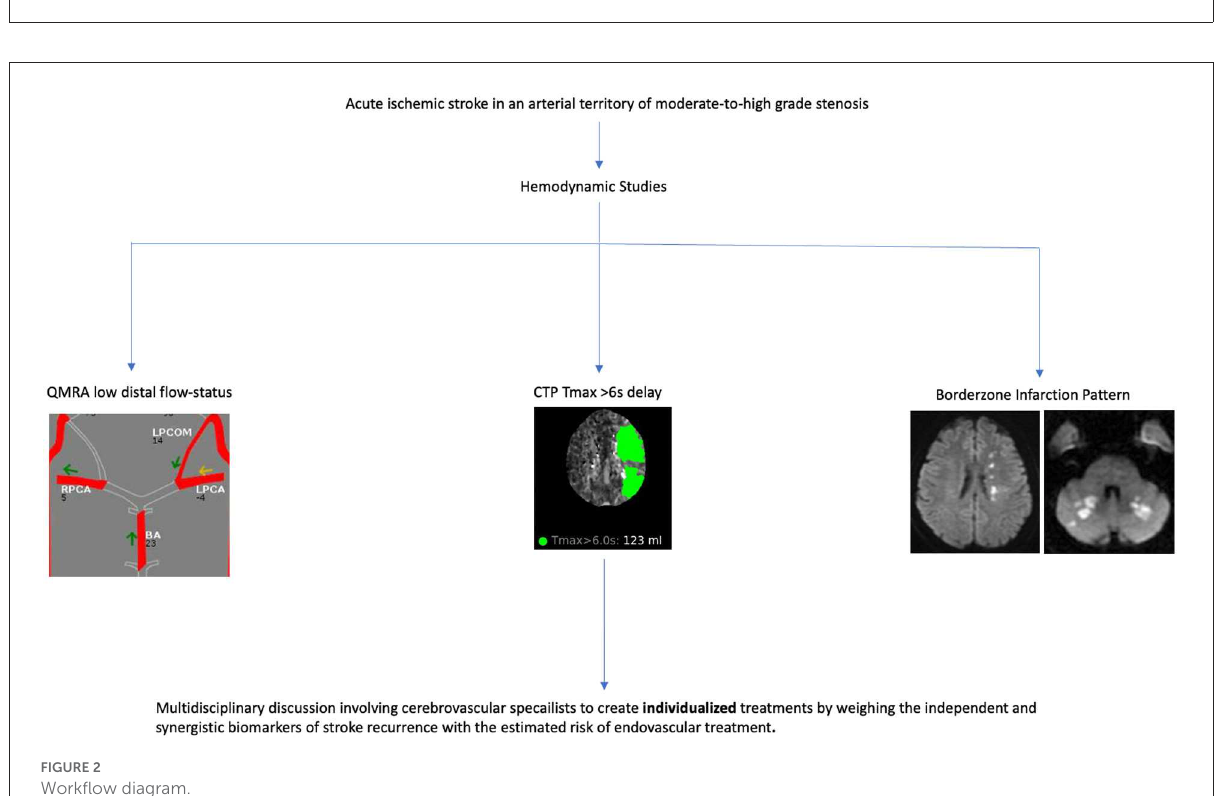
FIGURE2 Workflow